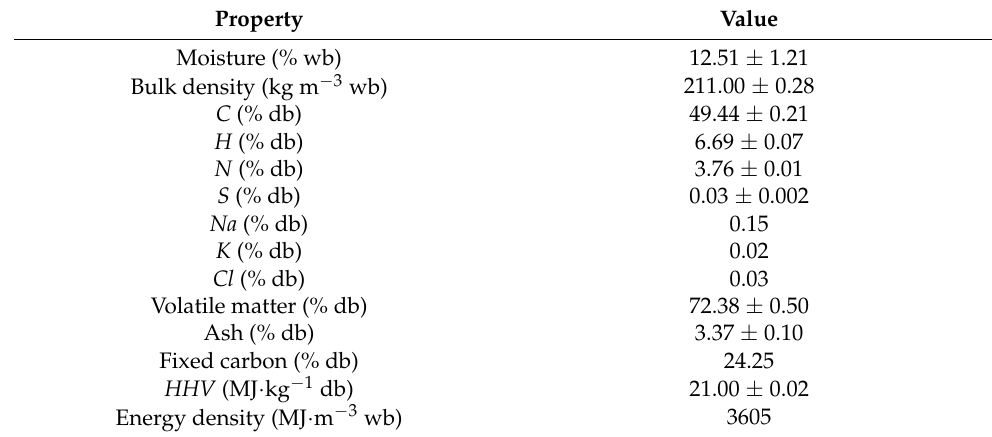
Table 2. Characterization of brewers’ spent grain samples before pelletizing. HHV , high heating value.